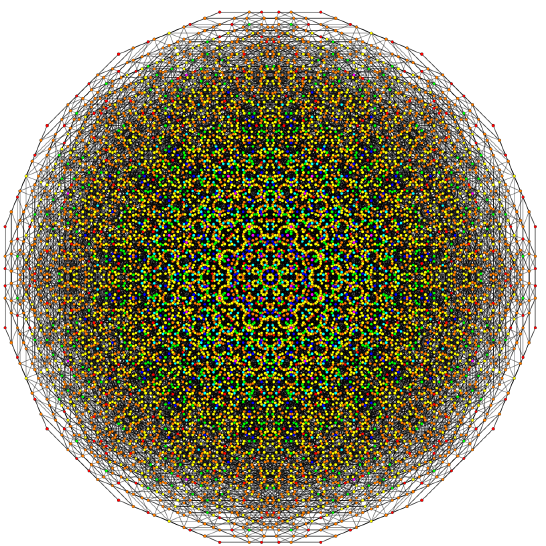
Figure 2 . The permutahedron of order eight, known as the omnitruncated 7-simplex, which exists in 7 dimensions and has 40,320